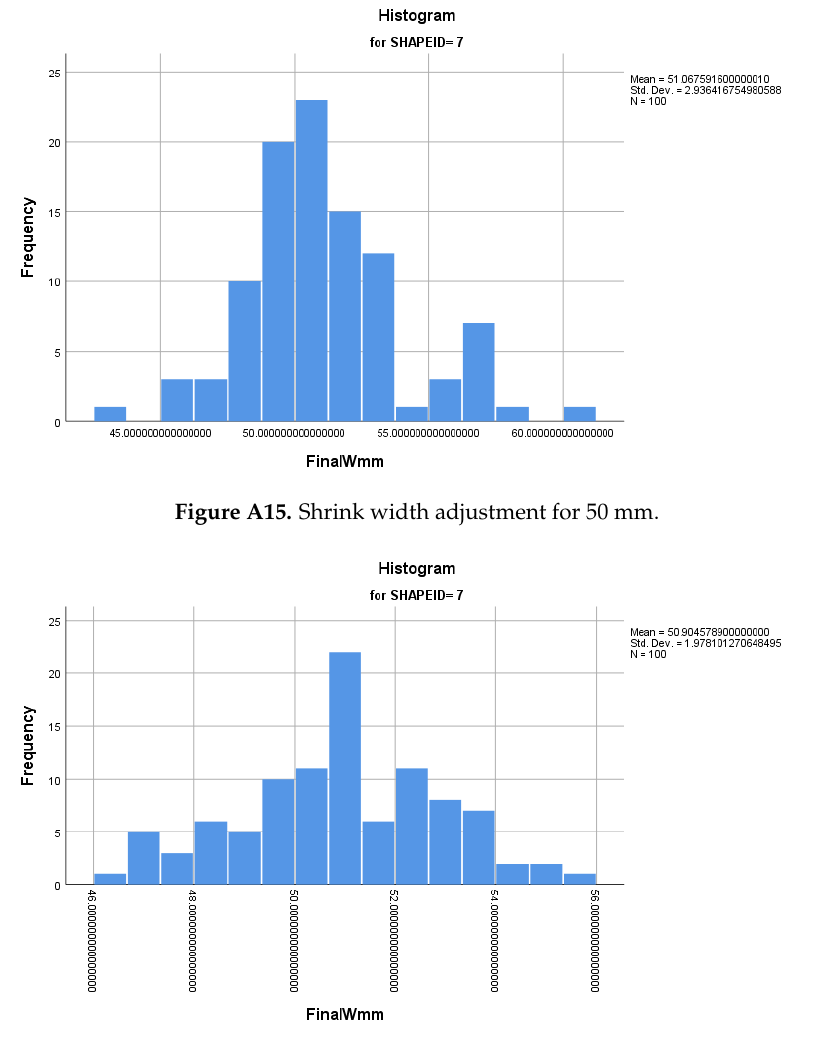
Figure A16. Grow width adjustment for 50 mm.